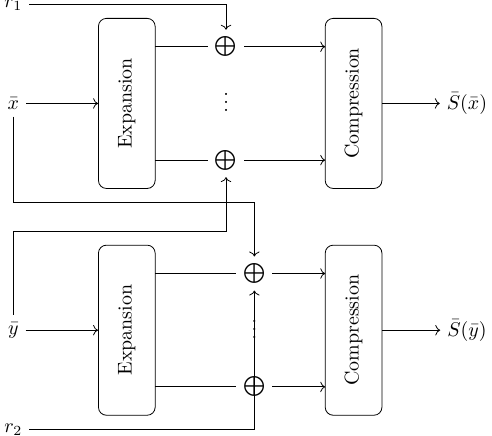
Figure 1: Depiction of the pairing of two masked